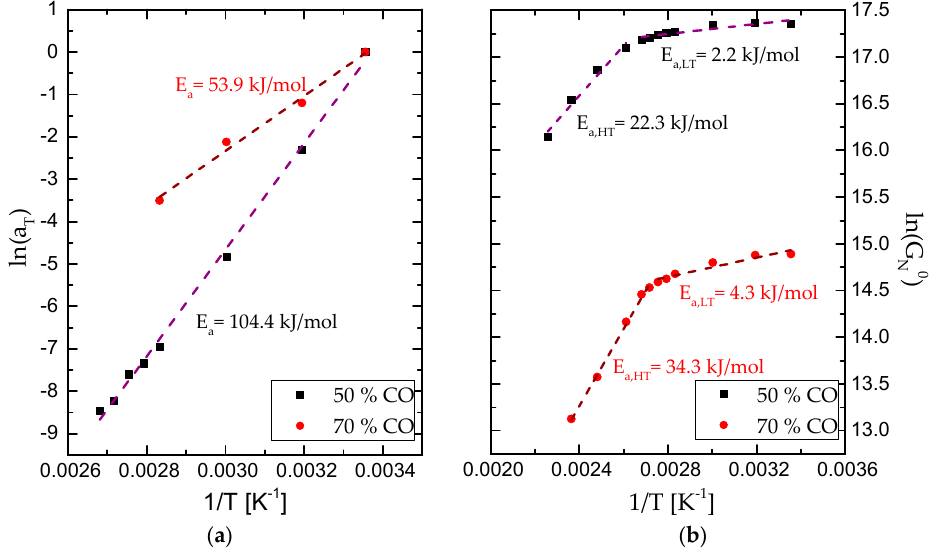
Figure 7. ( a ) Shift factors ( a T ) and ( b ) plateau moduli ( G N0 ) for formulations with 50:50 and 70:30 castor oil/biopolymer weight ratios.